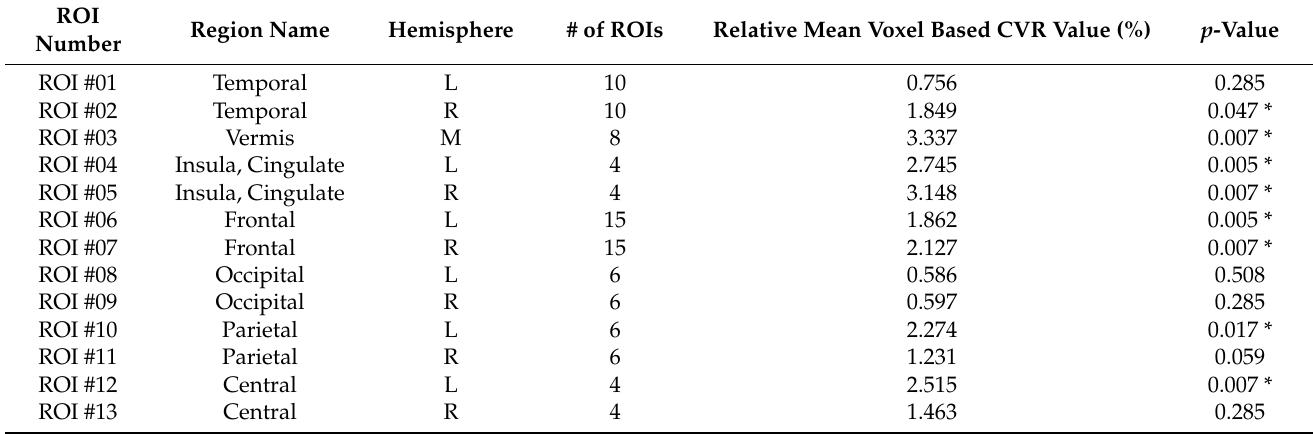
Table 2. The relative mean voxel-based CVR values and statistical p -values for non-parametric one-sample Wilcoxon t-test with a mean reference CVR value of − 2.28% in 13 subgroup